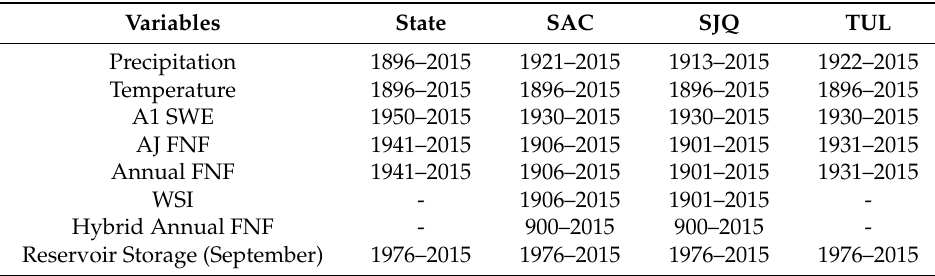
Table 2. Record period length of study